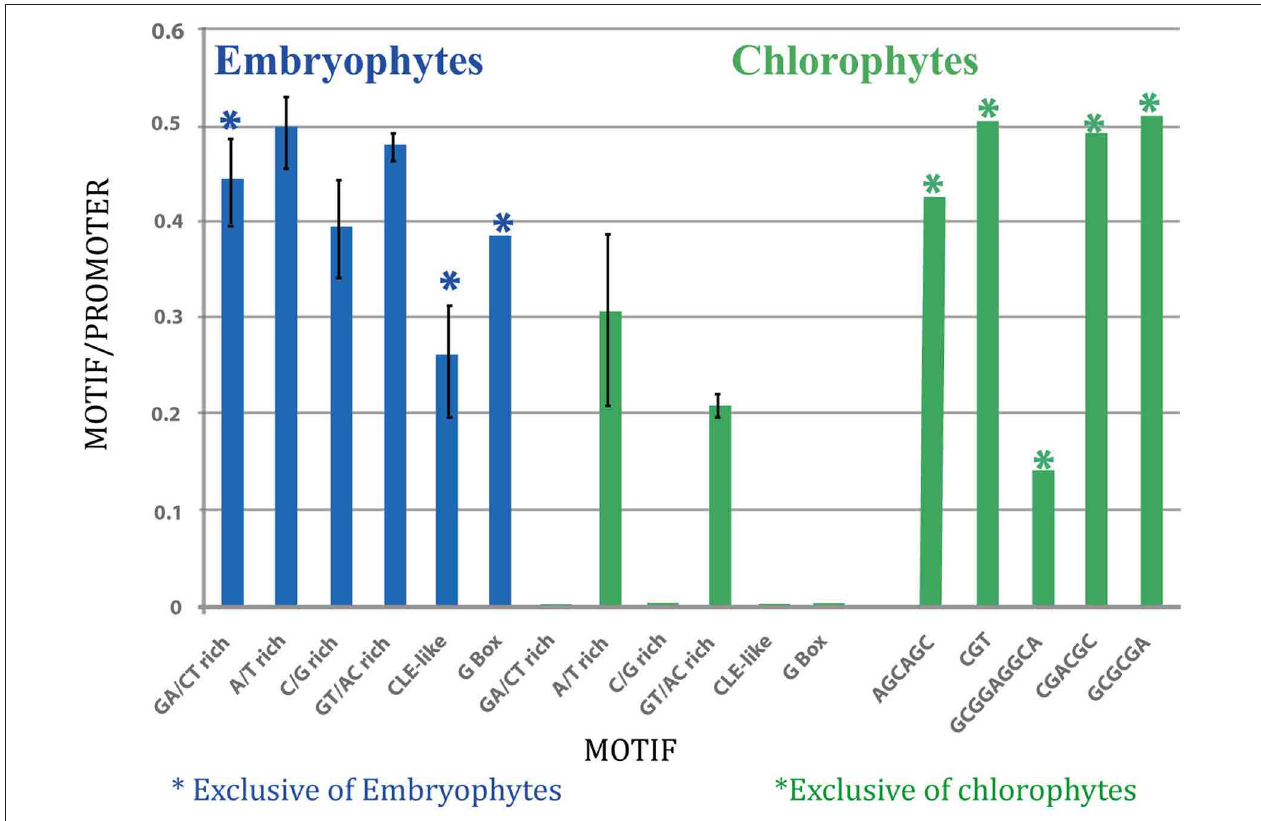
FIGURE 3 | Graphic representation of average number of motifs per promoter in embryophytes (left; blue), and in chlorophytes (right;